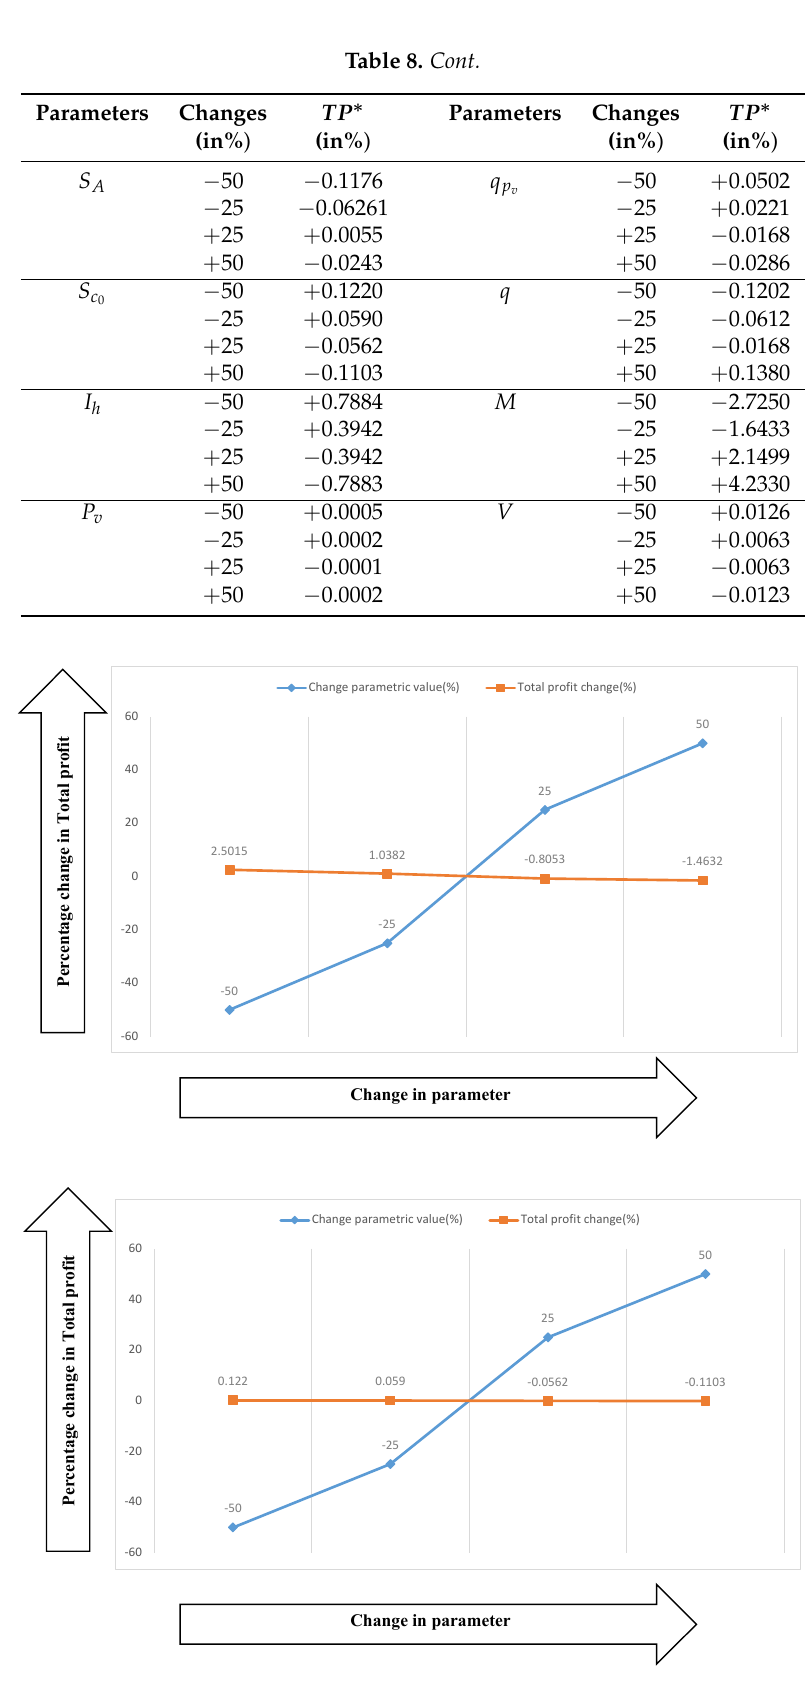
and S c versus percentage change in total profit, 0 0